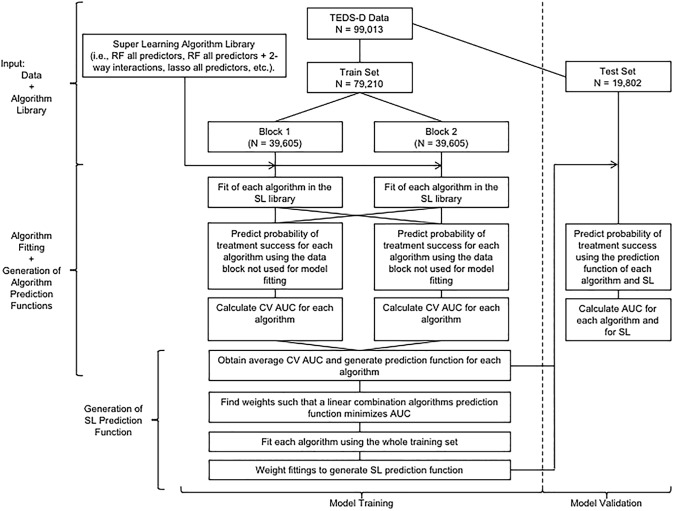
Analytic work flow.